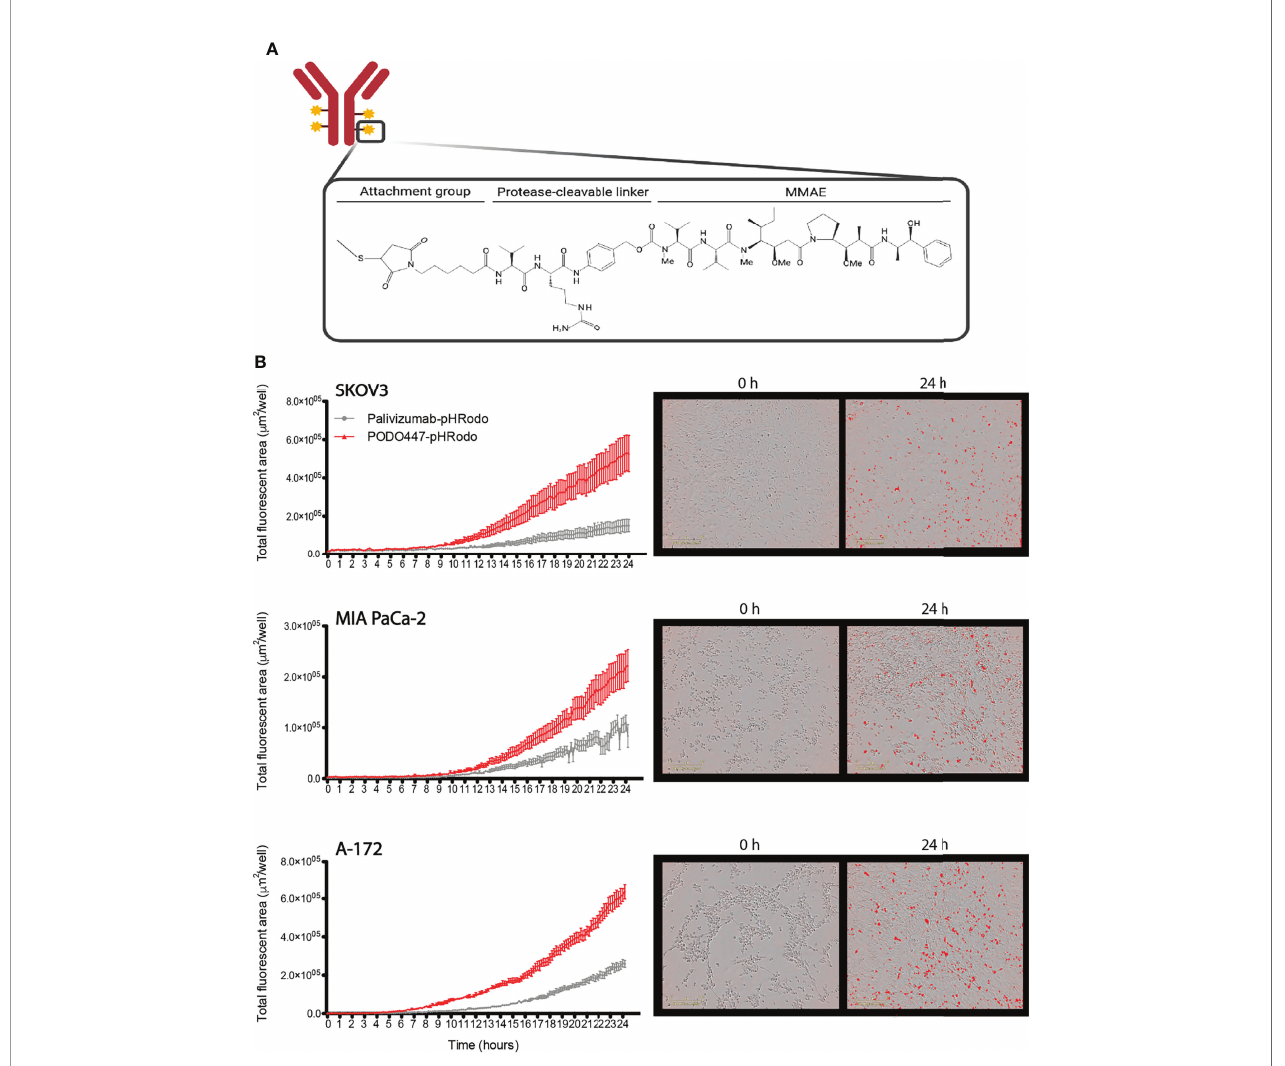
FIGURE 3 | PODO447 internalization on cancer cells. (A) Representative image of mAb-Vedotin structure (created with Biorender.com). (B) Internalization of PODO447- and palivizumab-pHRodo conjugates on SKOV3 ( P < 0.001), MIA PaCa-2 ( P < 0.001), and A-172 ( P < 0.001) cells. Left graphs show internalization over 24h as determined by Incucyte ® evaluation of the increase of total fl uorescent area per well. Pictures on the right are representative images of PODO447 internalization at 0- and 24-h